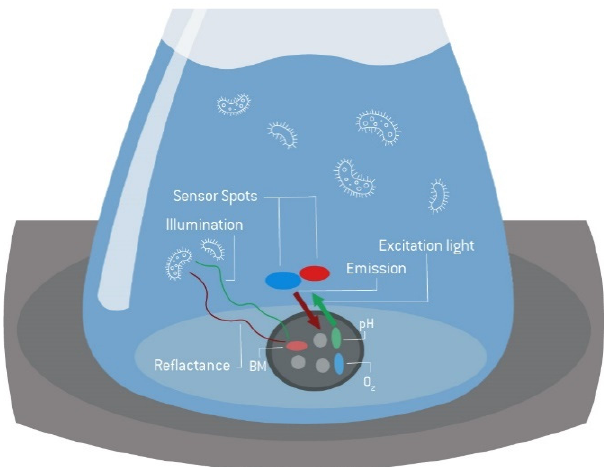
Figure 7. Measurement principle of the SFR vario. The biomass is measured via backscattered light, pH, and O 2, via integrated sensor spots. Backscattered light is measured using an LED with peak wavelength of about 605 nm and the reflected light is detected by a photodiode.